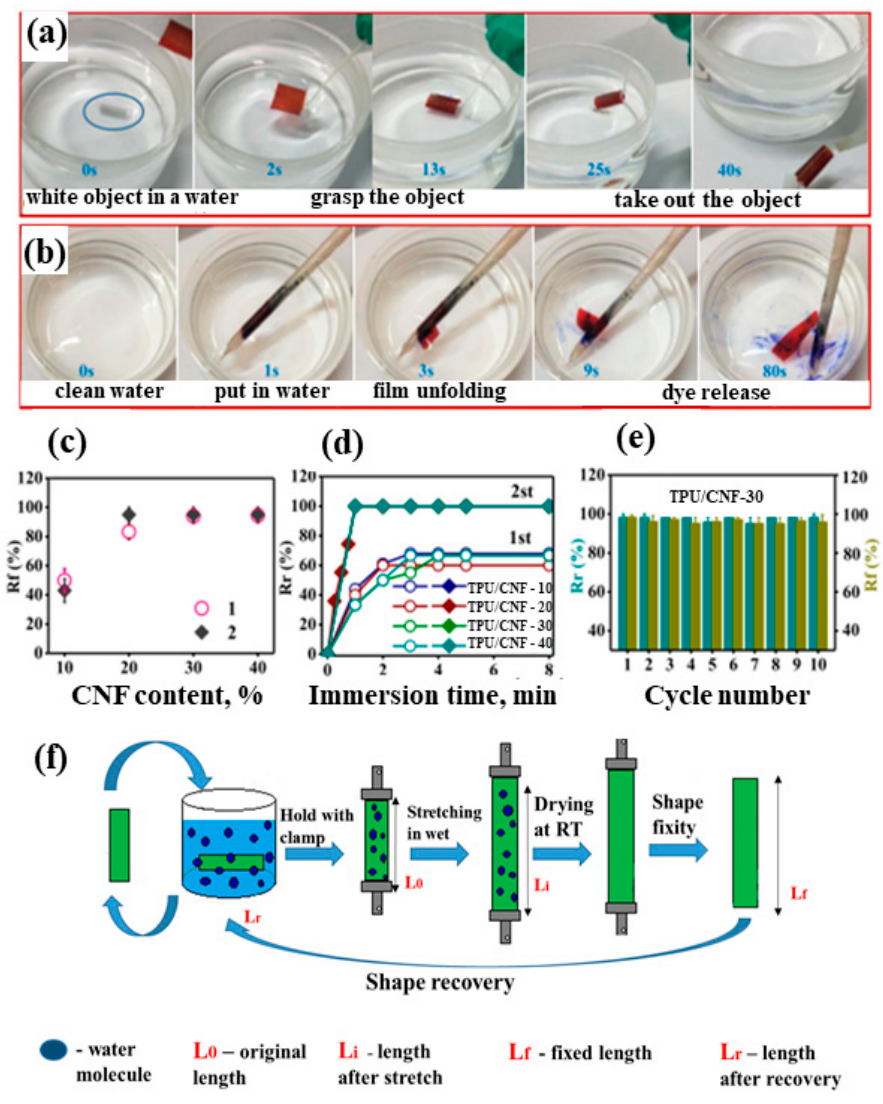
Figure 13. The grasp of the plastic target object from water ( a ) and the release of dye (methyl blue) in water ( b ), the dependence of R f on CNF content for composite films in the first (pre-stretch) and second testing cycle ( c ), the variation of R r with the immersion time for different composite films in first (pre-stretch) and second testing cycle ( d ), the statistic of R f and R r of the TPU/CNF composite film containing 30% CMF for 10 times cycles, indicating that the obtained film has good recyclability ( e ), the schematic illustration of the test process for water-induced SMP ( f ). Adapted from